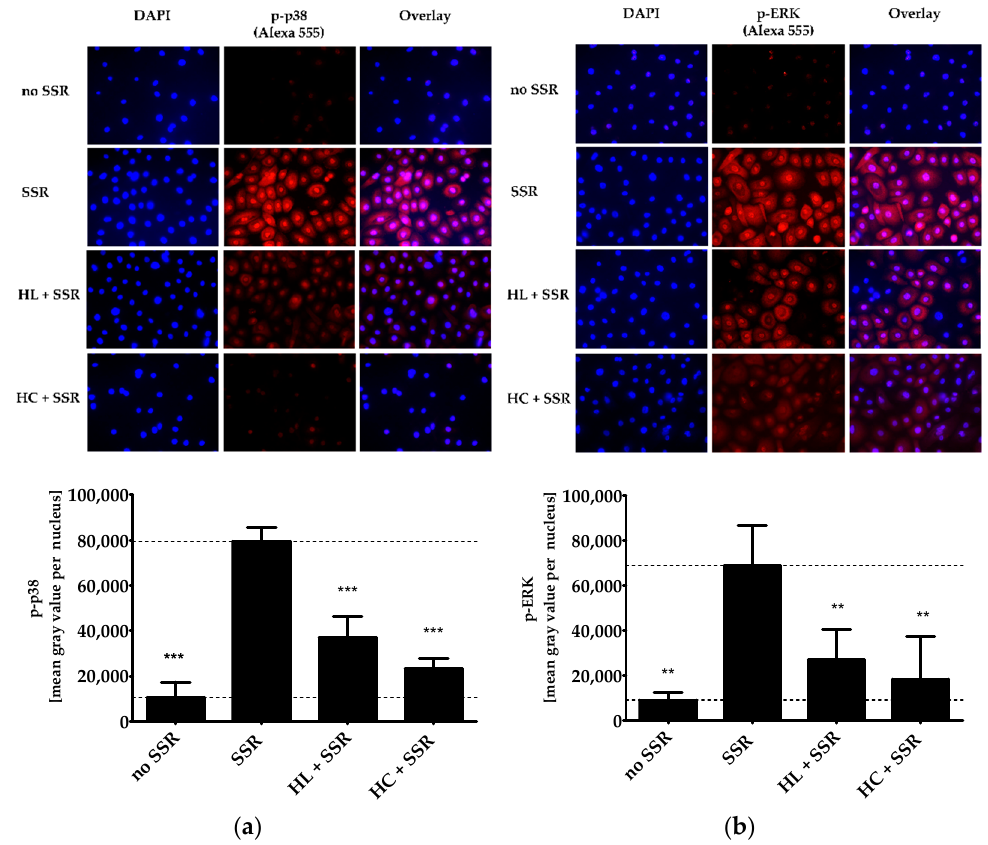
Figure 1. Effect of HL extract on the phosphorylation of p38 and ERK. PHKs were pretreated with HL extract (4 µg/mL) or HC (20 µg/mL) for 2 h and irradiated with 6 J/cm 2 using a solar simulator. After 20 min, immunofluorescence staining of p-p38 or p-ERK was performed. The nucleus was stained with DAPI. Representative pictures of p-p38 ( a ) and p-ERK staining ( b ) for non-irradiated PHKs (no solar simulator radiation (SSR)), after irradiation (SSR), with HL extract treatment before SSR (HL + SSR), and HC pretreatment before SSR (HC + SSR). The intensity of the staining in the nucleus was measured using the Intensity Ratio Nuclei Cytoplasm Tool (RRID:SCR_018573) in ImageJ. Results of three independent experiments are shown as mean ± SD. The statistical significances were calculated in relation to the SSR-treated sample. ** p ≤ 0.01, *** p ≤ 0.001. The activity of these MAPKs has been linked to the expression of the inflammatory cytokines IL-6 and IL-8 [23]. The cytokine IL-6 plays a central role in host defense and elevated levels are a marker for inflammation. The pro-inflammatory chemokine IL- 8 is produced by various cell types including keratinocytes to recruit leukocytes (e.g., neutrophils) to the site of radiation-induced skin inflammation [24]. HL extract also reduced the secretion of IL-6 and IL-8 after irradiation of PHKs (Figure 2a,b). The reduction in IL-6 release was not statistically significant between HL extract and HC, whereas with regard to IL-8 release, a significant difference was found, indicating a stronger effect of HC 0.05). ( p ≤